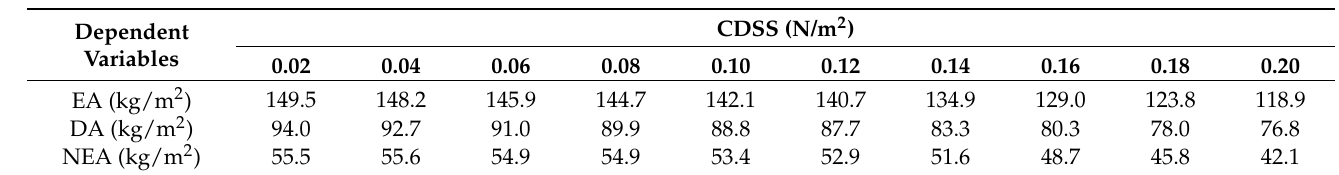
Table 2. Erosion amount (EA), deposition amount (DA), and net erosion amount (NEA) per unit area for different CDSSs after 100 years.